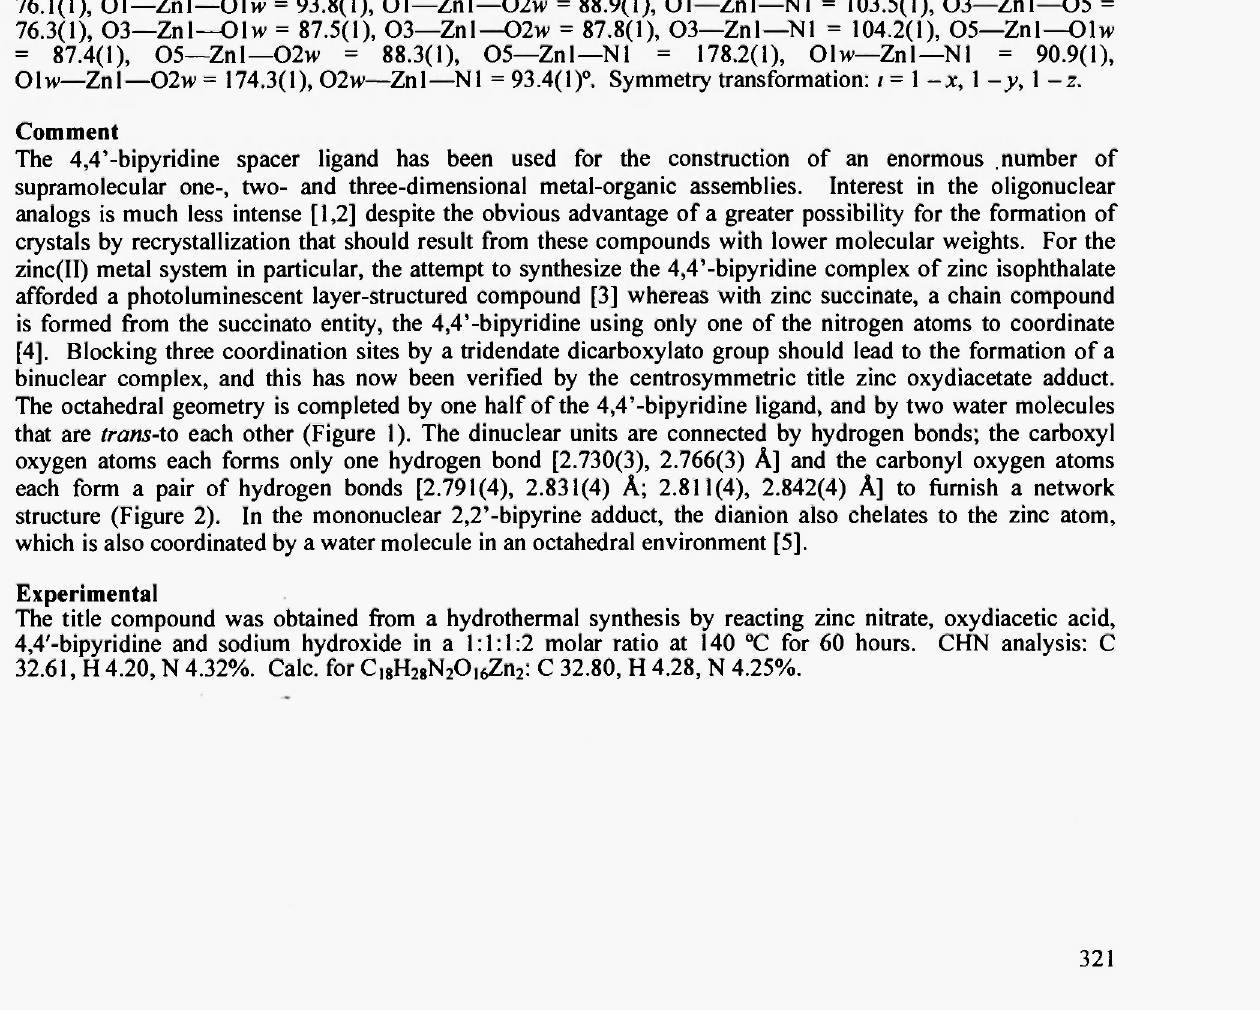
Figure 1. ORTEP plot of the centrosymmetric title complex at the 50% probability level. Selected bond distances and angles: Znl—Ol = 2.060(2), Znl—03 = 2.064(2), Znl—05 = 2.122(2), Znl—Olw